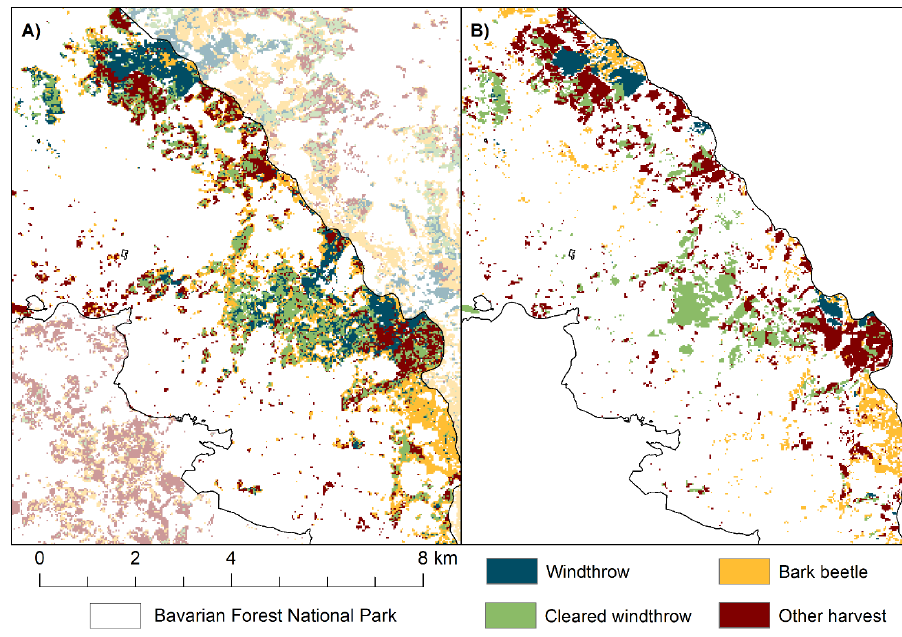
Figure 9. Comparison of ( A ) Landsat ‐ based disturbance agent map and ( B ) aerial survey data for a section of the Bavarian Forest National Park. Aerial survey polygons were rasterized at 30 m resolution for comparison with Landsat ‐ based predictions. The disturbances from other harvesting inside the national park were sanitation logging to control bark beetles.